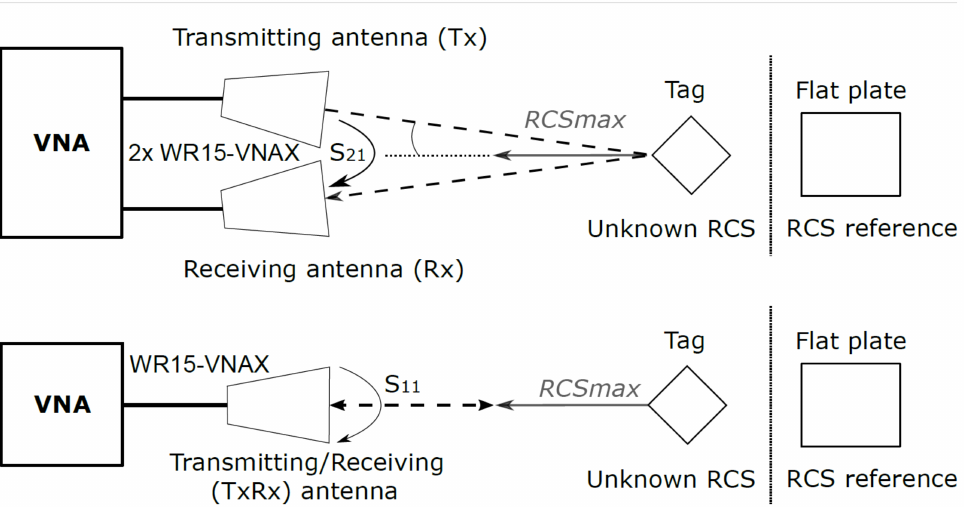
Figure 5. Schematic of the measurement setup in the anechoic